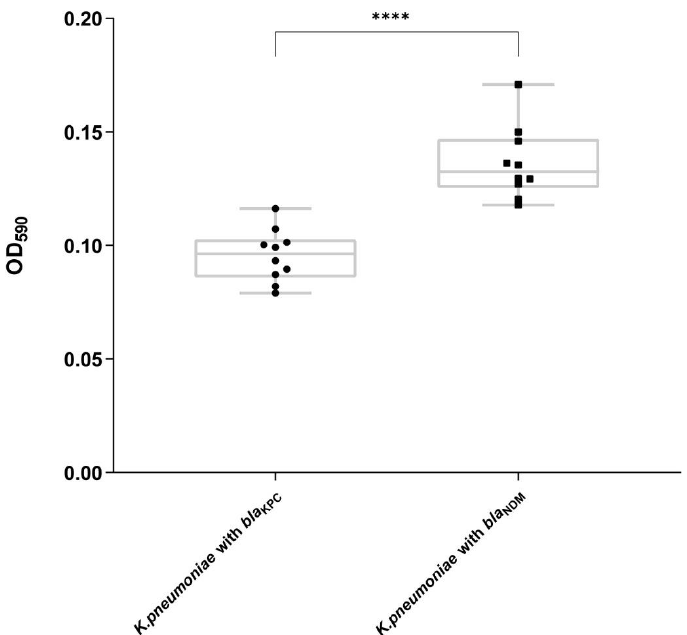
Figure 6. Biofilm formation. Circles indicate the ten Klebsiella pneumoniae carbapenemase 2 (KPC-2)- positive K. pneumoniae isolates; squares indicate the ten New Delhi metallo- β -lactamase (NDM)-1- positive K. pneumoniae isolates. **** means statistical significance ( p < 0.01) between K. pneumoniae - bla KPC and K. pneumoniae - bla NDM . Error bars represent standard deviation.